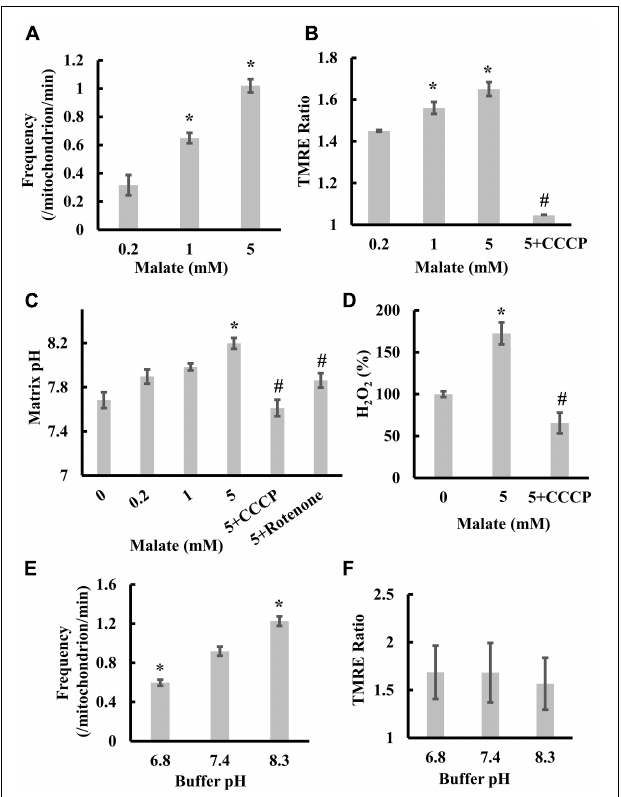
FIGURE 3 | Effects of matrix pH on ROS production. Mitochondria isolated from porcine hearts were measured. Before measurements, mitochondria were incubated with 5 nM valinomycin for 10 min at 25 ◦ C. (A) Fluorescence images of TMRE in individual mitochondria. S, a mixture of malate and glutamate was added at a final concentration of 1 mM for both substrates, then 25 mM K + was added. (B) Statistical analysis of TMRE ratio in individual mitochondria. S and K + were added as described for (A) . Control, mitochondria before the addition of substrates. (C) Time course of changes in matrix pH in a single mitochondrion. At t = 3 min, S was added. At t = 12.5 and 17.5 min, K + was added to mitochondria at a final concentration of 25 and 40 mM, respectively. (D) Effects of K + on ROS production. ROS production was measured in the presence of malate and glutamate. The H 2 O 2 production rate in the absence of K + was set to 100%. (E,F) Effects of buffer pH on matrix pH (E) and ROS production (F) . Measurements were performed in the buffer with 1 mM malate and 1 mM glutamate. 5 µ M CCCP was added. For (F) , the H 2 O 2 production rate in the buffer at pH 7.4 (-CCCP) was set to 100%. Values represent the mean ± SEM ( n > 50 for TMRE Ratio and matrix pH. n = 3 for ROS). *p < 0.05 vs. control for (B) ; vs. 0 mM for (D) . In (E,F) , *p < 0.05 vs. pH 7.4 without CCCP, # p < 0.05 vs. pH 7.4 with